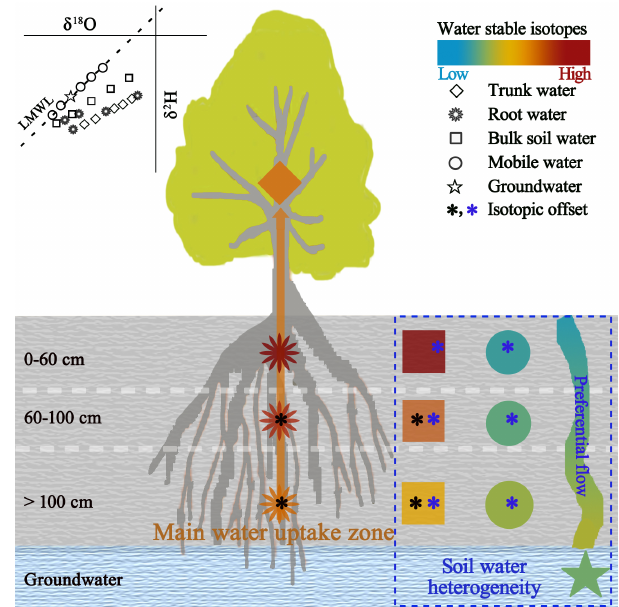
Figure 7. Schematic diagram of isotopic dynamics along the soil– root–trunk continuum. Colour codes indicate the isotopic composi- tions of mobile water, bulk soil water and root water at the indicated depths, as well as those of groundwater and trunk water (colours range from from blue to brown, representing low to high values). The upper left inset is a conceptual dual-isotope plot. A black as- terisk indicates a significant difference in isotopic offset between root water and bulk soil water at the same depth ( p< 0.05). A blue asterisk indicates a significant difference in isotopic offset between mobile water and bulk soil water at the same depth ( p<